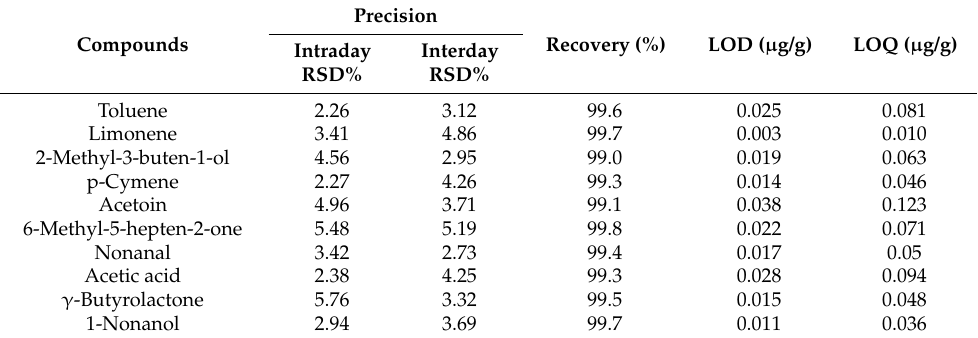
Table 3. Quality parameter of volatile compounds detected under the optimized HS-SPME-GC– MS